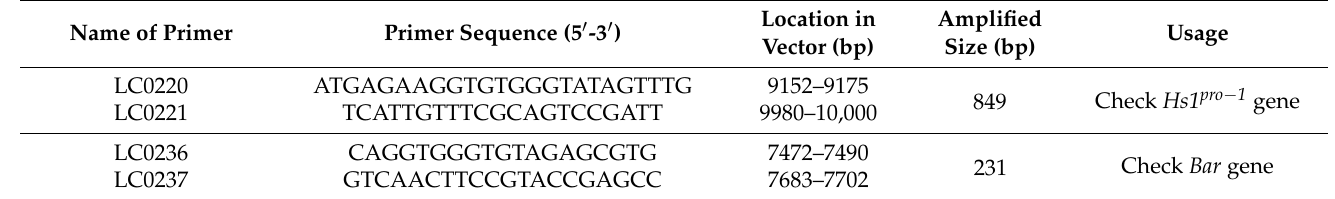
Table 7. Name of primer, primer sequence (5 (cid:48) -3 (cid:48) ), location in the vector (bp), amplified size (bp), and usage of Southern probes for checking Hs1 pro − 1 and Bar